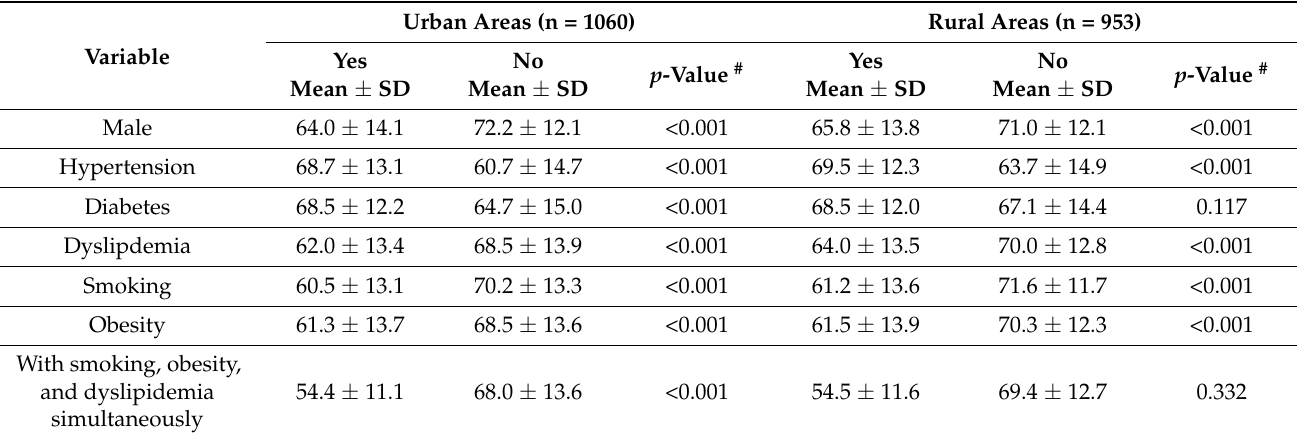
Table 2. The onset age of AMI with and without conventional risk factors by